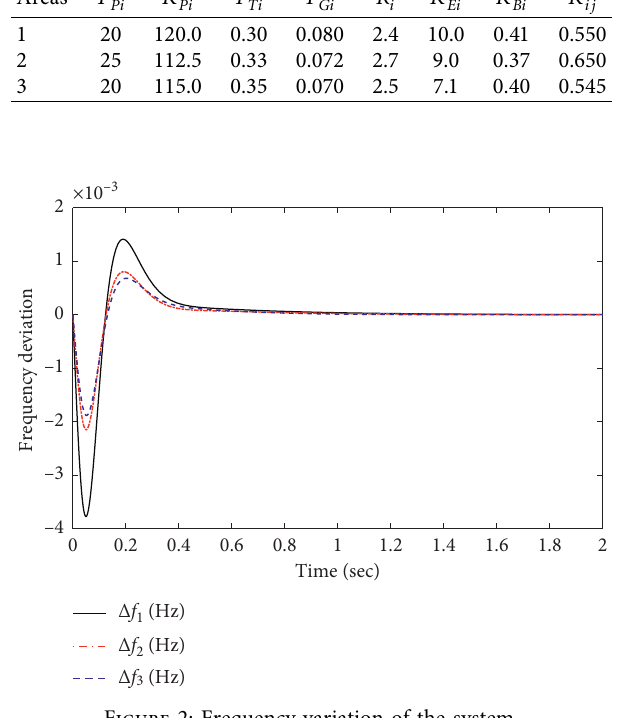
Figure 2: Frequency variation of the system.